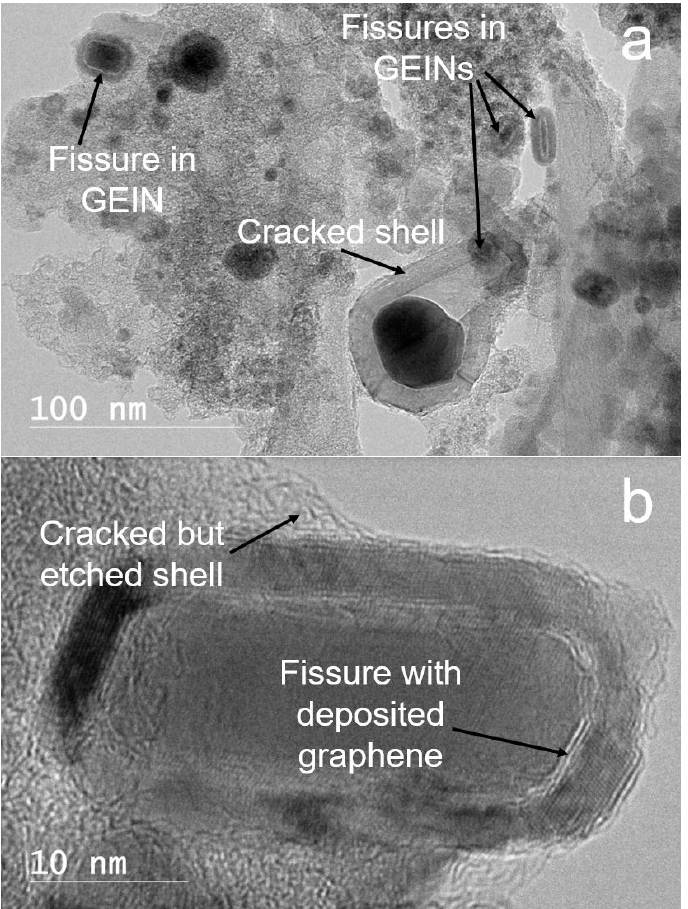
Figure 4. HRTEM images of GEIN sample ( a ) and a single GEIN ( b ) catalytically cracked by H 2 at 900